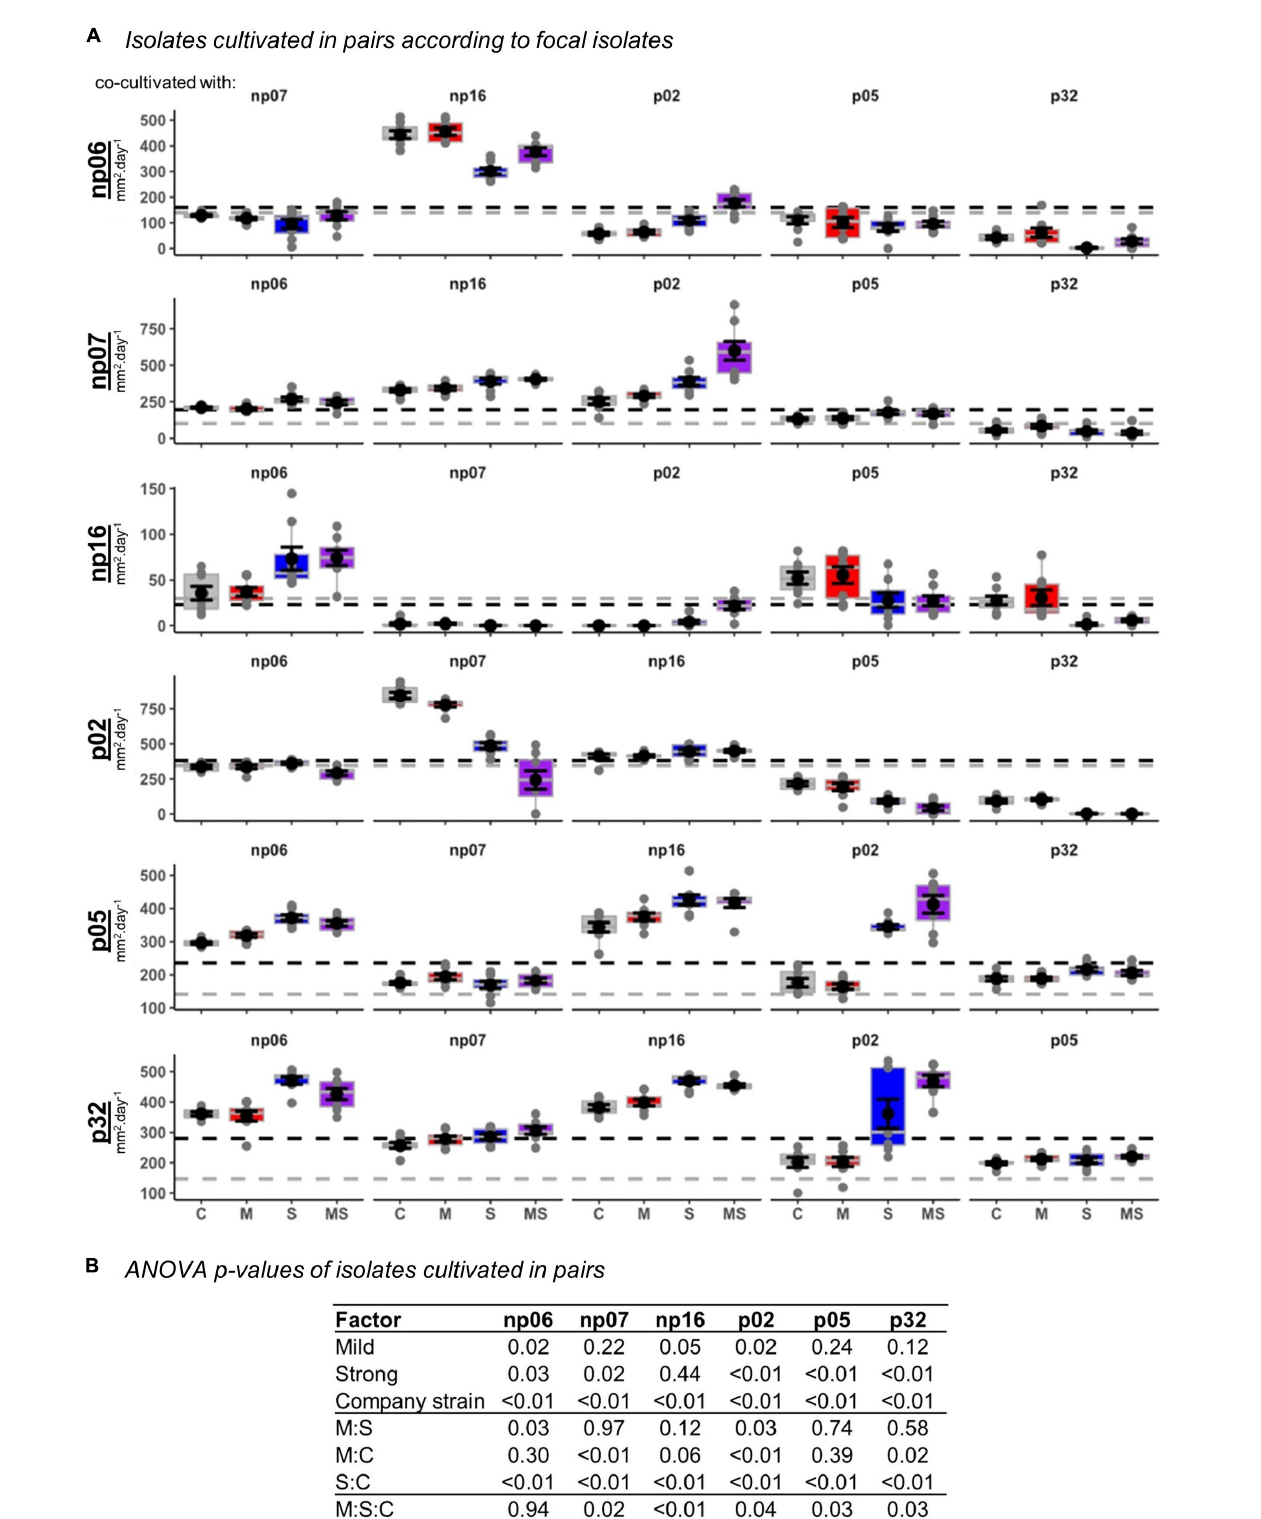
FIGURE2 The effects of none (control, C), mild (M), strong (S), and both (MS) heat stress events on fungal isolate growth rates for fungal isolates cultivated in pairs. The panel containing box-plots with average and standard error for each focal isolate according to the pairs (A) , and the robust analysis of variance (rANOVA) p -values for the isolates analyzed in a factorial design considering the heat treatments mild (yes or no), strong (yes or no) and company strains combinations (B) . For the boxplots, the gray lines are references to the isolates growing alone in control conditions (data from Supplementary Figure 2 ) and the black lines are the average of all controls for each focal